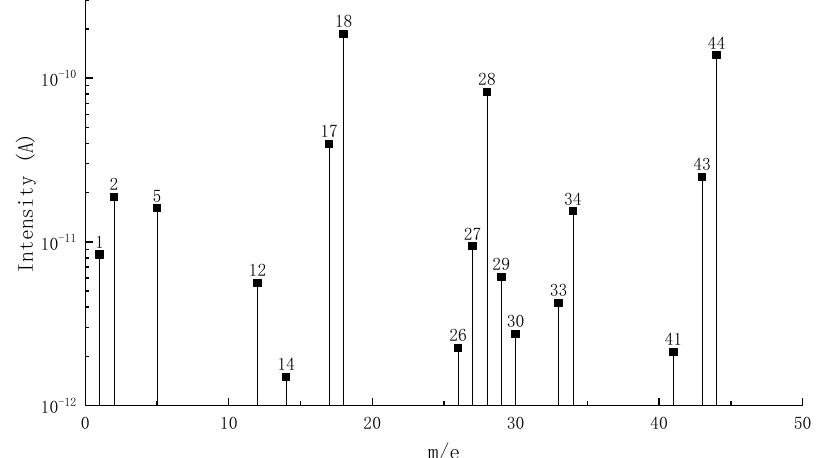
Figure 4. Mass spectrum of volatile matter from pyrolysis combustion of epoxy asphalt at characteristic temperature (440.8 °C).